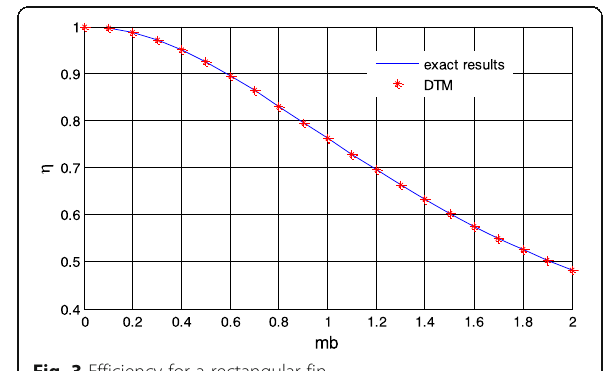
Fig. 2 Temperature evolution for a rectangular fin Fig. 3 Efficiency for a rectangular fin